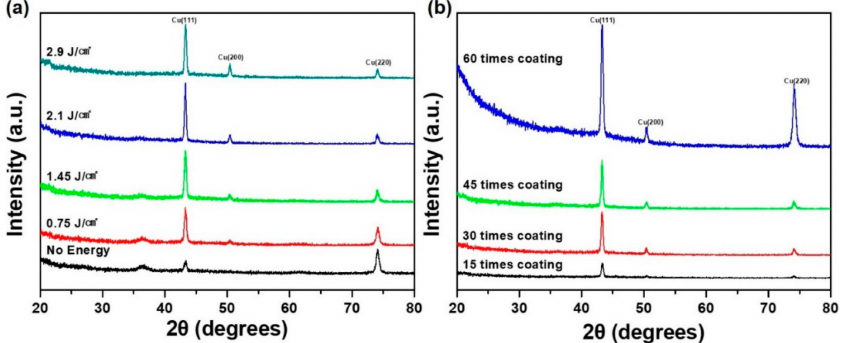
Figure 5. X-ray di ff raction spectra. ( a ) XRD pattern of Cu NPL with various irradiations. ( b ) XRD pattern of Cu NPL with various layers of coating.